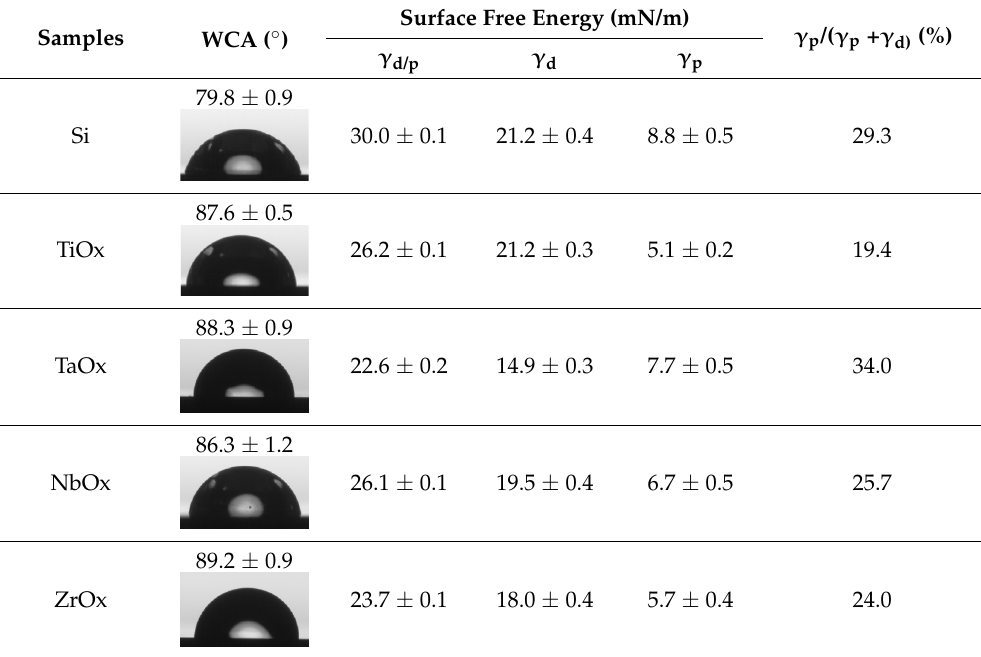
Table 4. Water Contact Angle (WCA) and Surface Free Energy (SFE) of uncoated and coated silicon surfaces with metal oxides thin films.